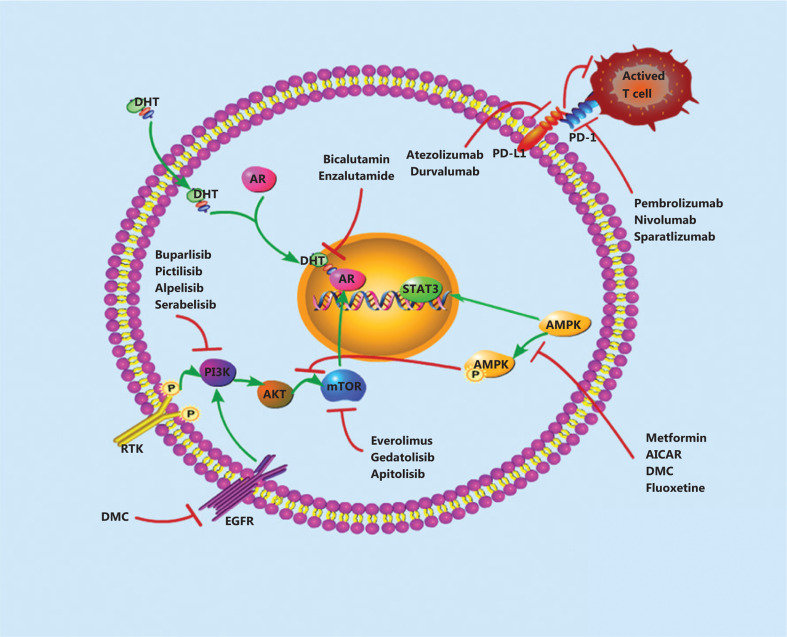
A model showing current therapeutic strategies that could be combined with other therapies. The therapeutic strategies include AR-inhibitors, PI3K/AKT/mTOR inhibitors, AMPK inhibitors, and immunotherapy.